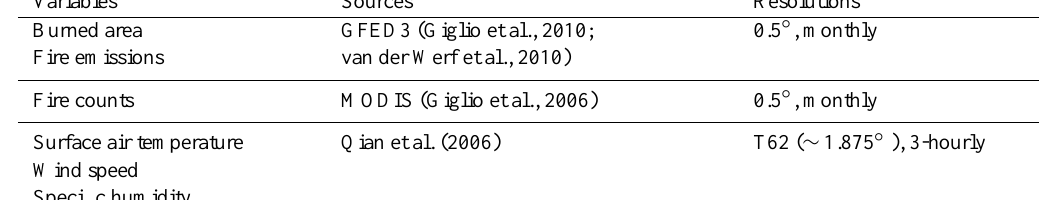
Table 1. Datasets. Note that default datasets in CESM1 that are just used to drive the model are not included here.